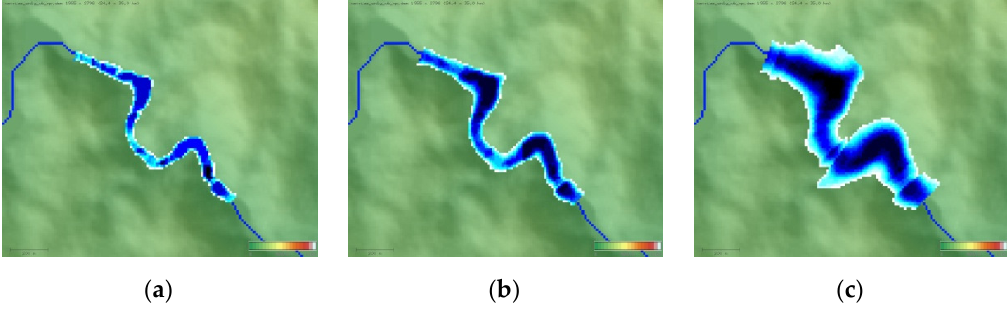
Figure 36. Flood inundation mapping for three di ff erent discharges: ( a ) 400 m 3 / s; ( b ) 4000 m 3 / s; and ( c ) 40,000 m 3 /